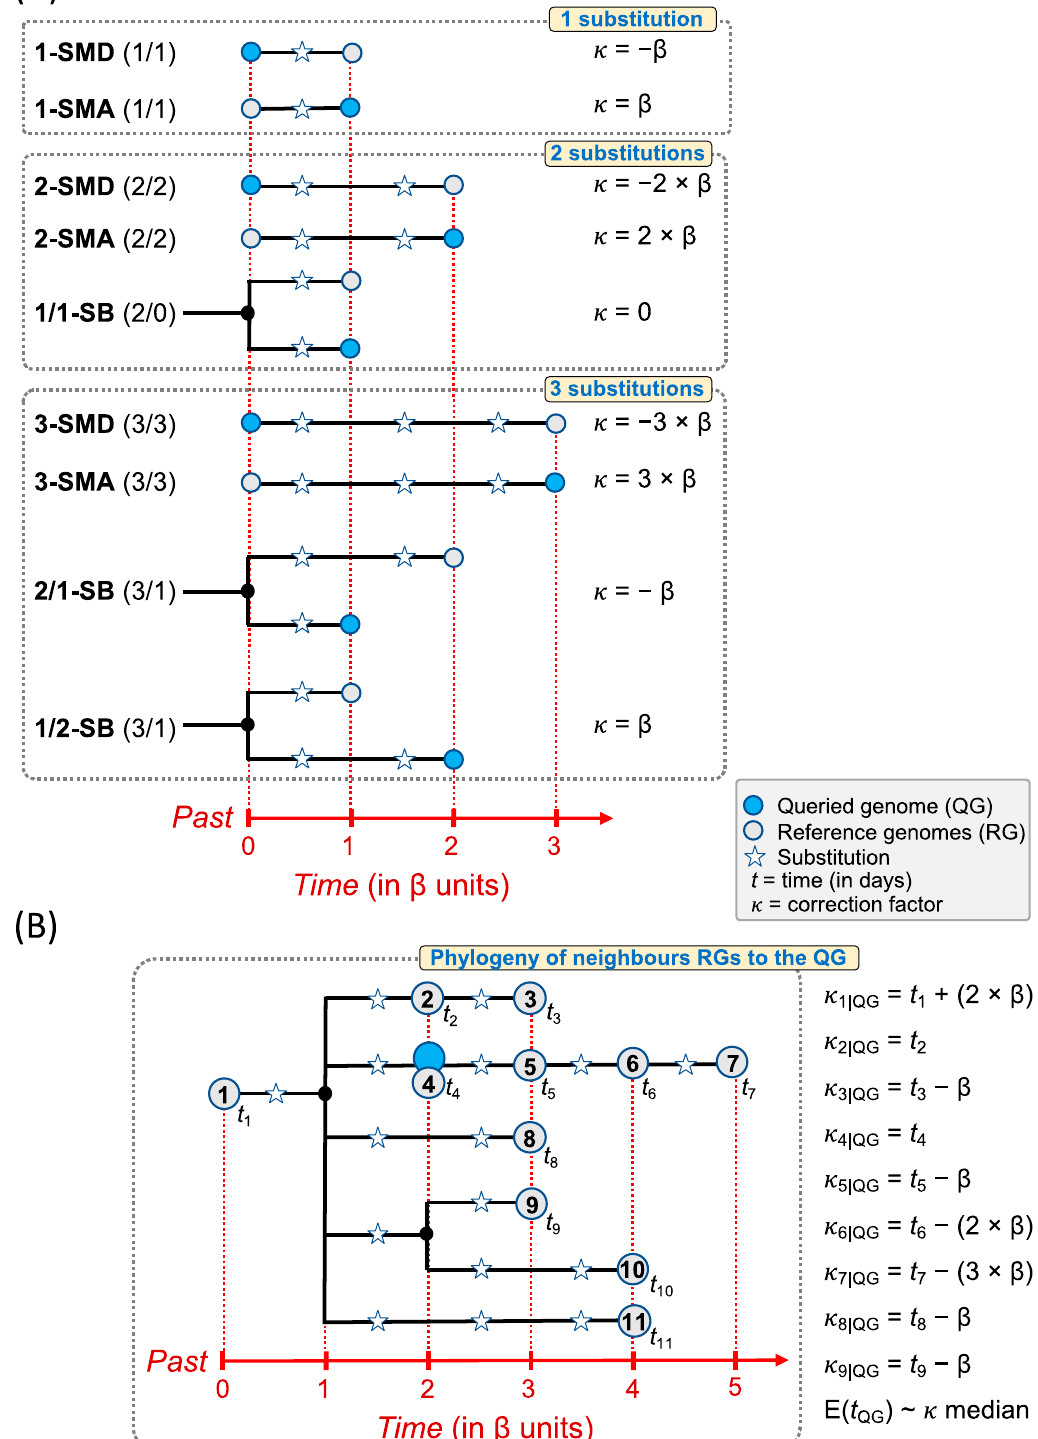
Figure 2. Diagram showing the procedure for sampling time corrections for the reference genomes (RG) of a given queried genome (QG). ( A ) The time of a QG ( t E-QG ) can be estimated using sampling dates of phylogenetically close RGs (t R-RG ). The figure shows all the most parsimonious evolutionary possibilities connecting a QG to an RG when differing by 1, 2, or 3 substitutions. A way to estimate the age of the QG is to apply a correction factor κ to the neighbor RGs; this factor depends on the number of substitutions separating the QG and the RG, the shape of the phylogeny and the time needed to accumulate one substitution in circulating SARS-CoV-2 genomes ( β ). ( B ) Diagram show- ing the procedure to estimate the age of a queried genome (QG; t QG ) using sampling dates of RGs from a hypothetical phylogeny of closely related genomes. Only RGs differing by 0, 1, 2, 3